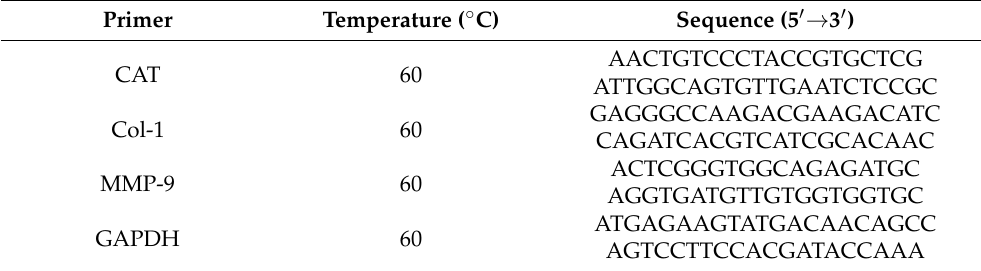
Table 2. Primer sequence for